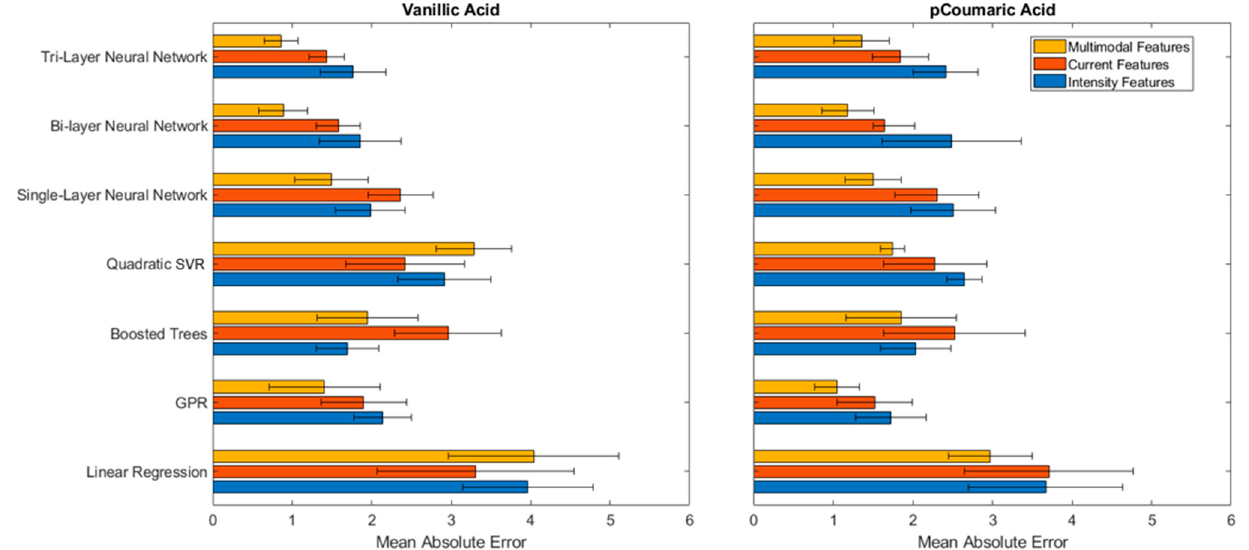
Figure 5. MAE of various ML models using multimodal combined extracted features versus subset of current or intensity features for Vanillic and p -Coumaric acids. The error bars represent the standard deviation from test results following five-fold cross validation method.